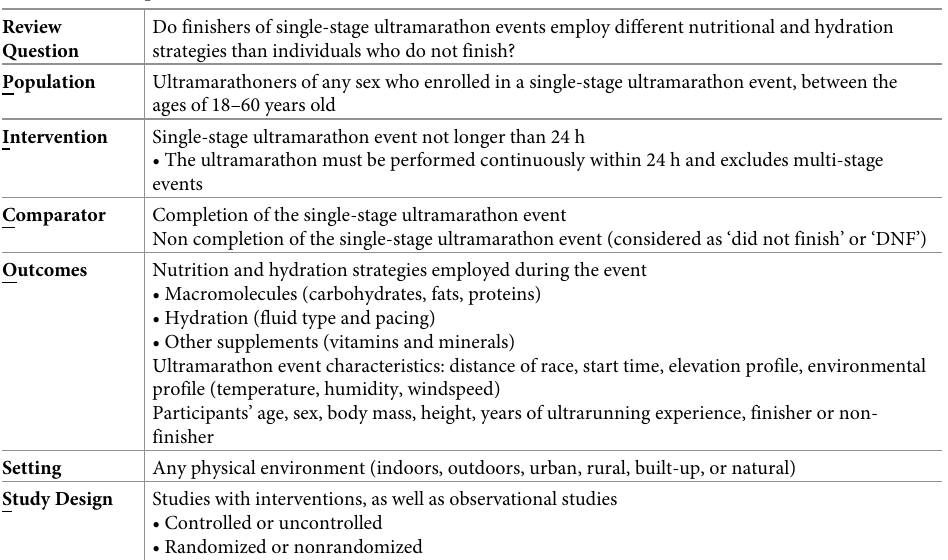
Table 1. Review question and PICOS